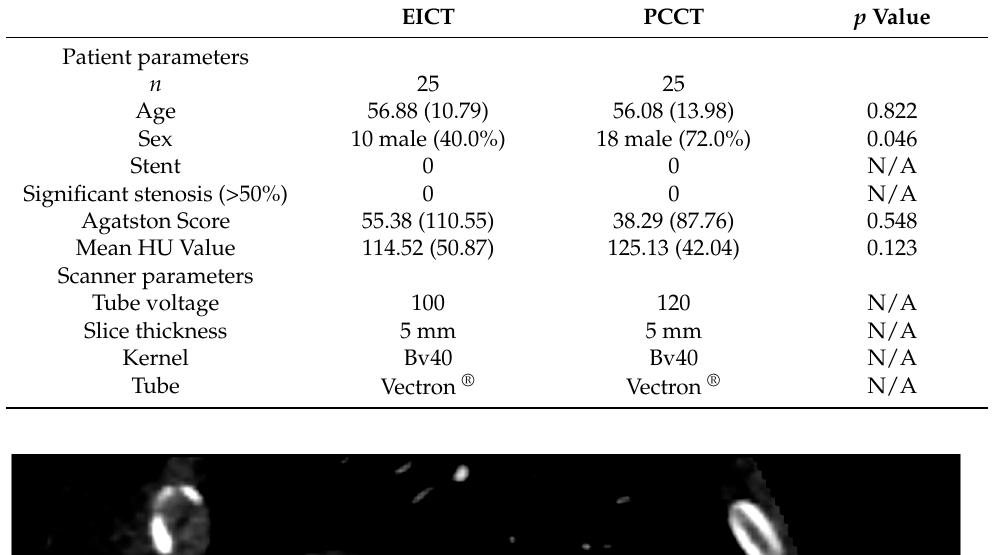
Table 1. Patient collective overview. Mean and (SD) given for continuous variables.